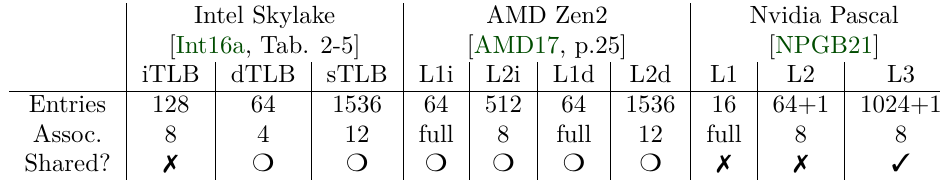
Table 1: Overview of typical TLB parameters using the example of some recent processors. The Nvidia L2- and L3-TLB feature a victim slot where the least recently evicted entry is held (denoted as +1 ). ✓ : Shared between cores, ❍ : Shared between hyperthreads, ✗ : Not shared